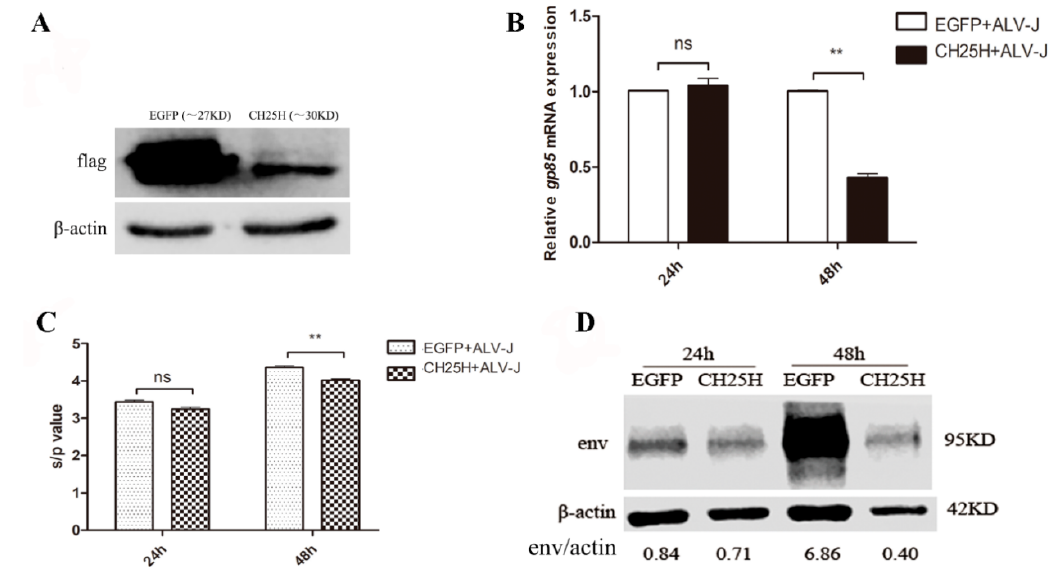
Figure 5. Overexpression of chCH25H inhibits ALV-J replication. ( A ) Exogenous CH25H and EGFP genes was expressed in DF1 cells at 24 h post transfection. ( B ) The expression of SCAU-HN06 gp85 gene was detected by qPCR in DF1 cells at 24 and 48 hpi. ( C ) The expression of ALV-J p27 protein was detected by ELISA in DF1 cells at 24 and 48 hpi. ( D ) Expression levels of the ALV-J envelope protein in DF1 cells were detected by Western blotting using mouse antibody JE9. “CH25H” on the graph represents overexpression of CH25H in DF1 cells. “EGFP” represents control. ** p < 0.01.